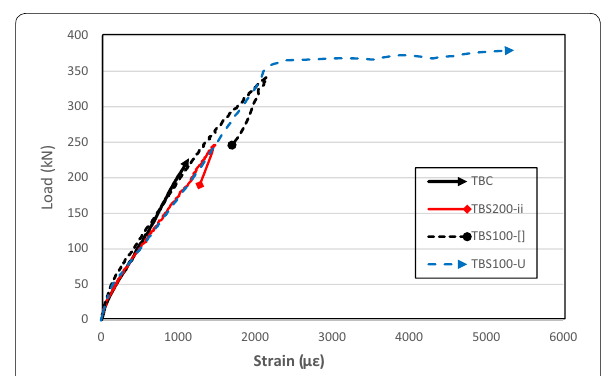
Fig. 11 Load versus longitudinal steel strain underneath the load